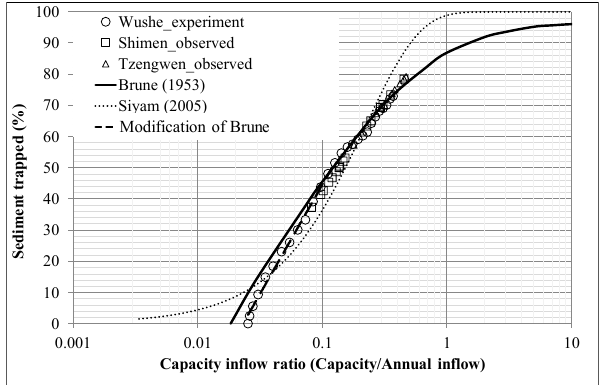
Figure 10. Relationship of the capacity inflow ratio and the trap efficiency.